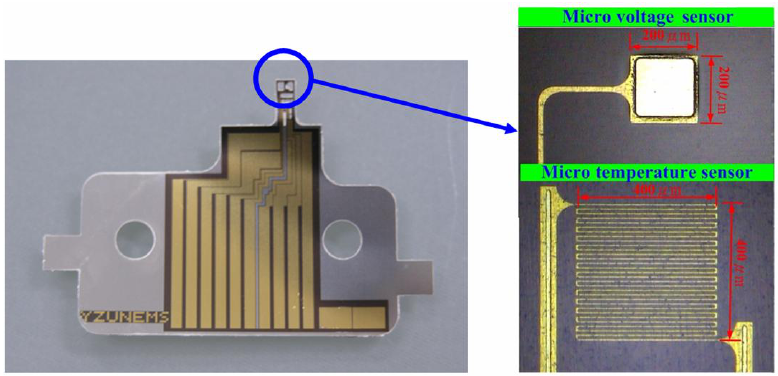
Figure 3. Optical microscopic photograph of micro temperature and voltage sensors.